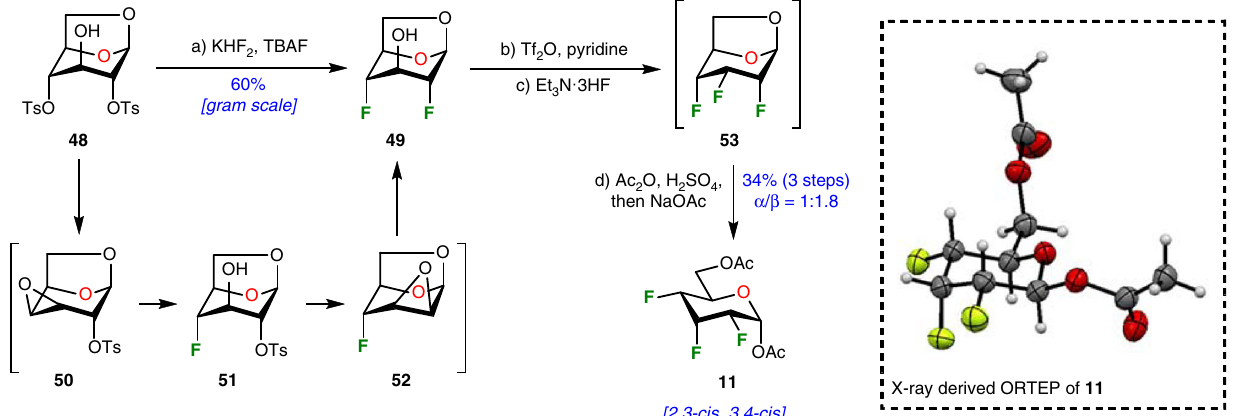
Fig. 7 Rapid synthesis of 2,3,4-trideoxy-2,3,4-tri fl uoroallopyranose 11 . Reagents and conditions: (a) KHF 2 (4 equiv), TBAF·3H 2 0 (8 equiv), 180 °C, 24 h, 60%; (b) Tf 2 O (1.5 equiv), pyridine (3 equiv), CH 2 Cl 2 , rt, 0.5 h; (c) Et 3 N·3HF (100 equiv), 120 °C, 20 h; (d) Ac 2 O (30 equiv), H 2 SO 4 (10 equiv), 0 °C to rt, 16 h, then NaOAc (20 equiv), rt, 0.3 h, 34% over 3 steps, α / β = 1:1.7. Ac 2 Oacetic anhydride, NaOAc sodium acetate, TBAF tetrabutylammonium fl uoride, Tf 2 O tri fl uoromethanesulfonic anhydride. ORTEP diagram of the molecular structure of 11 showing 50% thermal ellipsoid probability, carbon (gray), oxygen (red), fl uorine (light green), hydrogen (white)